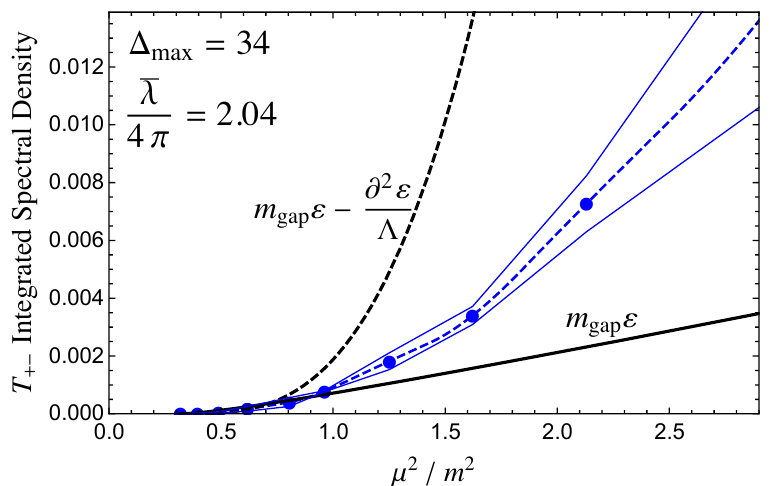
Figure 14 . Integrated spectral density for T + (cid:0) at (cid:1) max = 34 and (cid:22) (cid:21) Ising model prediction with (dashed line) and without (solid line) the correction from @ 2 " , with (cid:3) = 1 : 0. In the IR, the e(cid:11)ects from this leading correction are negligible, such that we can safely m ignore them. For reference, the numerical results are the same as those in the lower left plot in (cid:12)gure